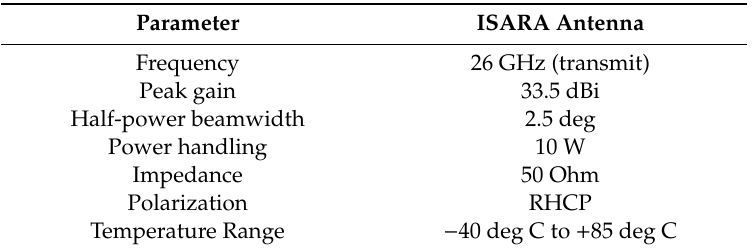
Table 3. ISARA’s antenna